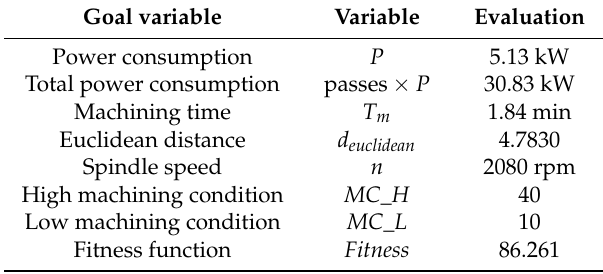
Table 14. Goal variables evaluation of the heavy roughing operation